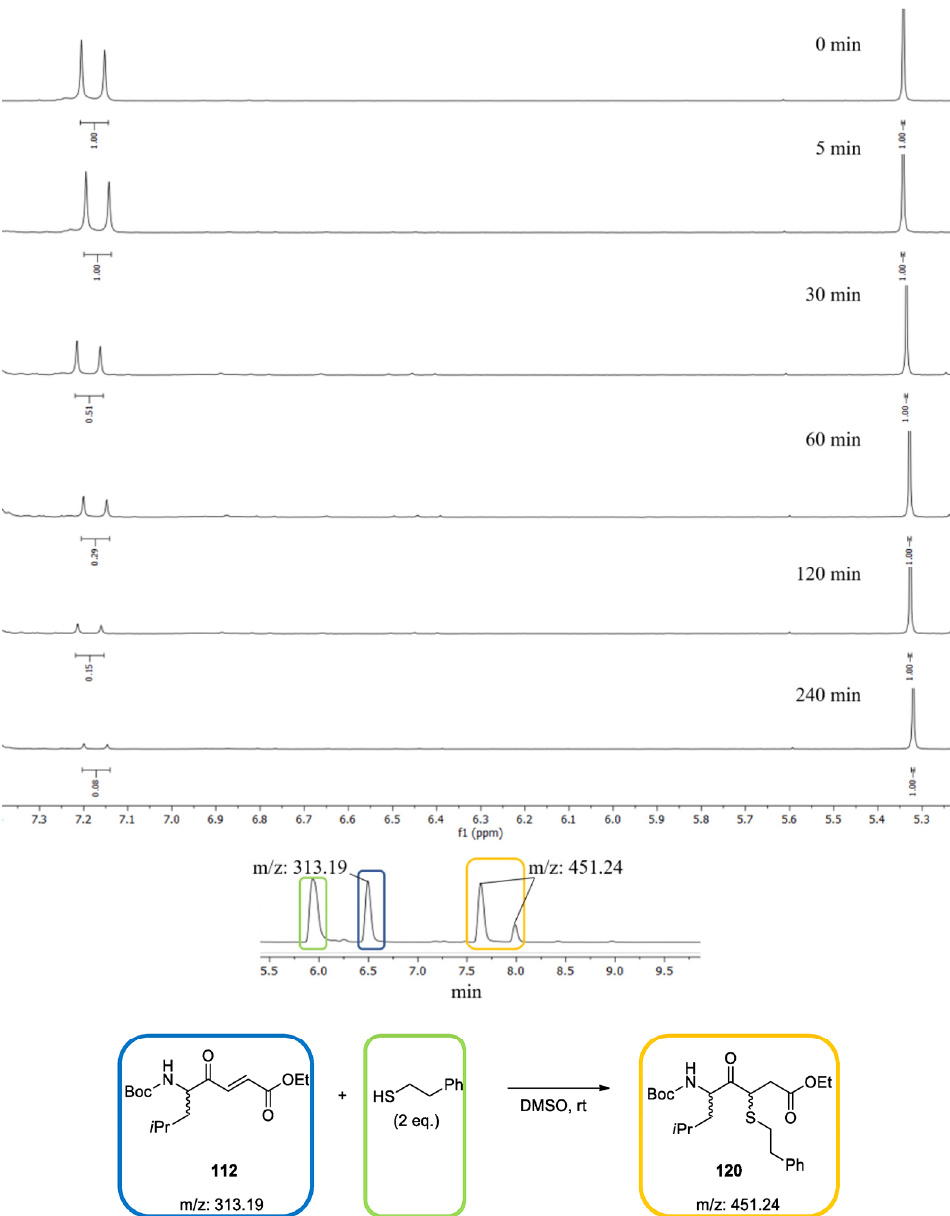
Figure 2. 1 H-NMR spectra of the 4-oxoenoate 112 before the addition (0 min) and after 5, 30, 60, 120 and 240 min reaction time with 2-phenylethanthiol in the absence of triethylamine. The integrals of the β -proton of the double bond at 7.17 ppm in relation to the 2-CH 2 signal of the internal standard 1,3-dioxolane at 5.3 ppm are given. LC-MS analysis of the same reaction at 30 min. Method B (LC-MS): The reactivity of the β -lactam test compound 108 with the nucle- ophiles was investigated using an LC-MS-based method. To quantify the conversion, the AUCs were determined at 254 nm. In Figure 3, the UV spectra of the test reaction of the β -lactam 108 with EtONa are shown exemplarily. After one hour, complete conversion of the inhibitor to the adduct 122 was observed.